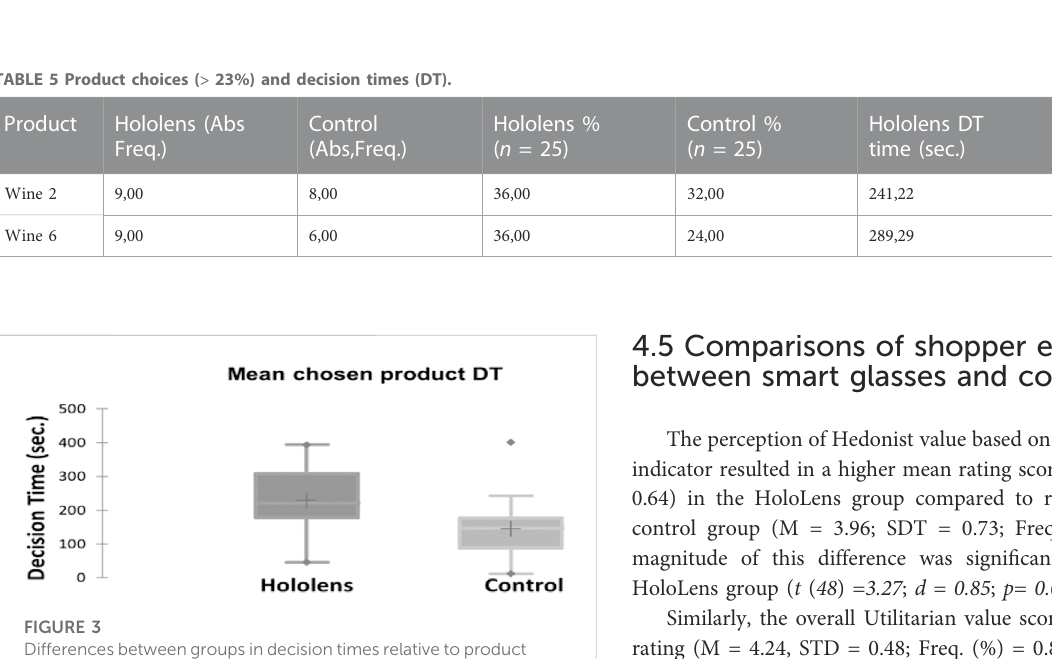
TABLE 4 Mean product interaction frequency. Group Hololens ( N = 25)